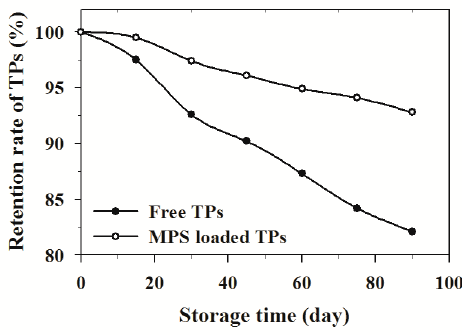
Figure 5. Storage stability of TPS adsorbed onto MPS at ambient temperature.